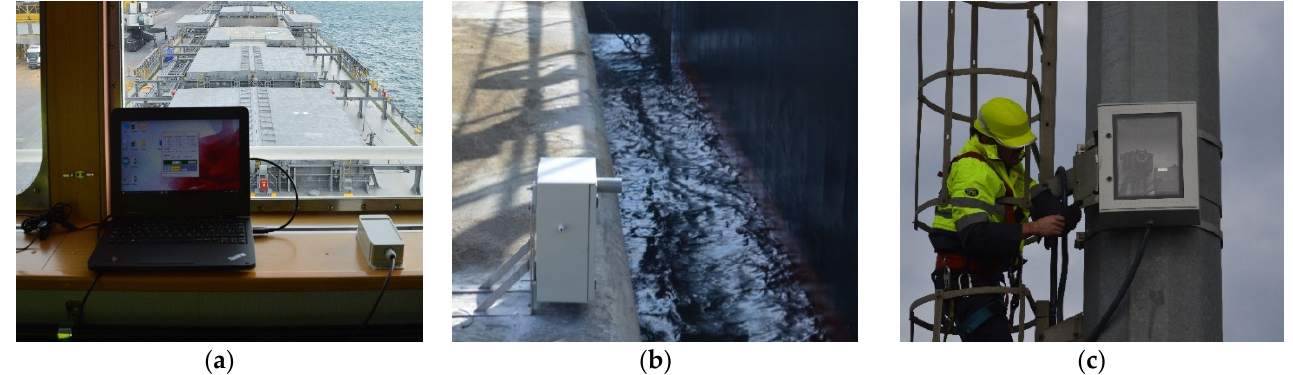
Figure 3. The ship movement measurement system comprises an IMU ( a ), two laser distance meters ( b ) and two cameras ( c ).